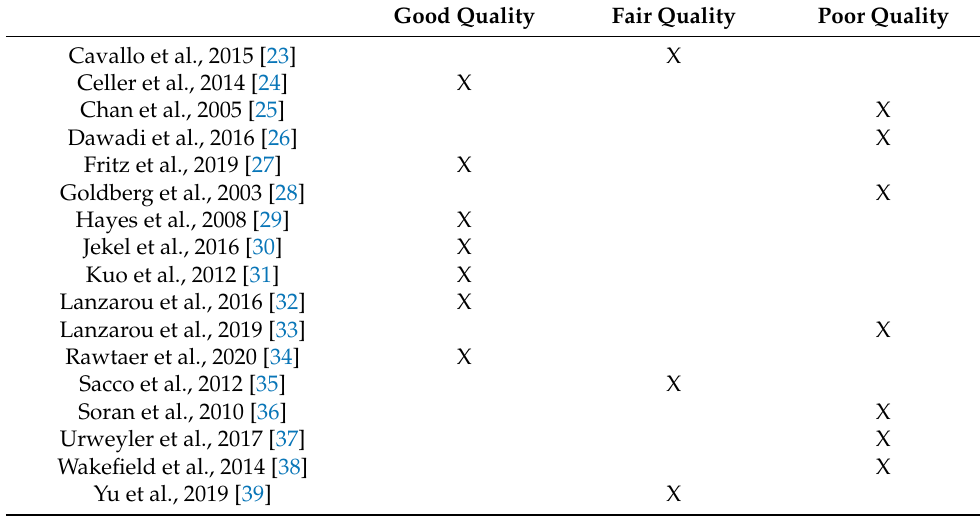
Table 1. Summary of quality